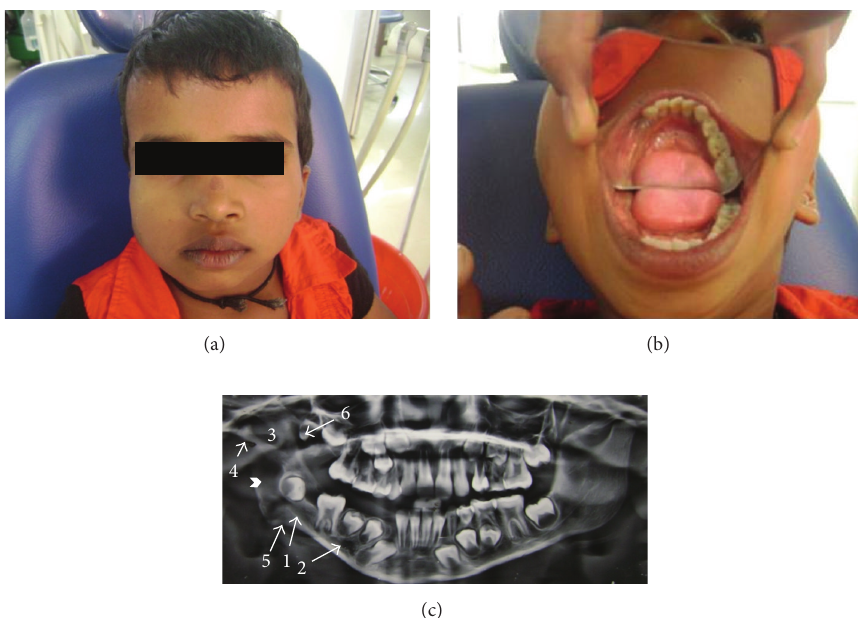
Figure 1: (a) Extraoral frontal view shows swelling on right side of face, (b) intraoral view shows alveolar enlargement and missing teeth on right side, (c) OPG shows intraosseous radiolucency (chevron) with impacted 46, enlarged mandibular canal (1), enlarged mental foramen (2), deep sigmoid notch (3), narrow condyle and pseudoelongation of condylar neck (4), notching of gonial angle (5), and supernumerary tooth in maxilla